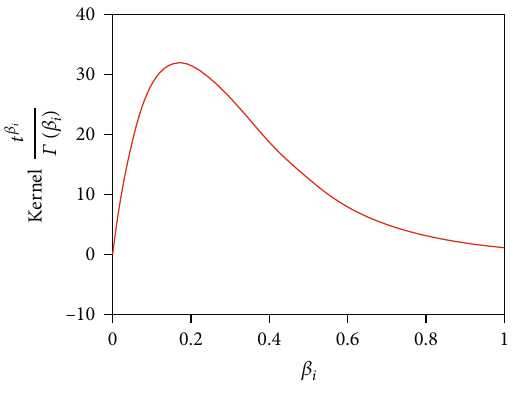
Γ ð β Þ with the fractional i / i